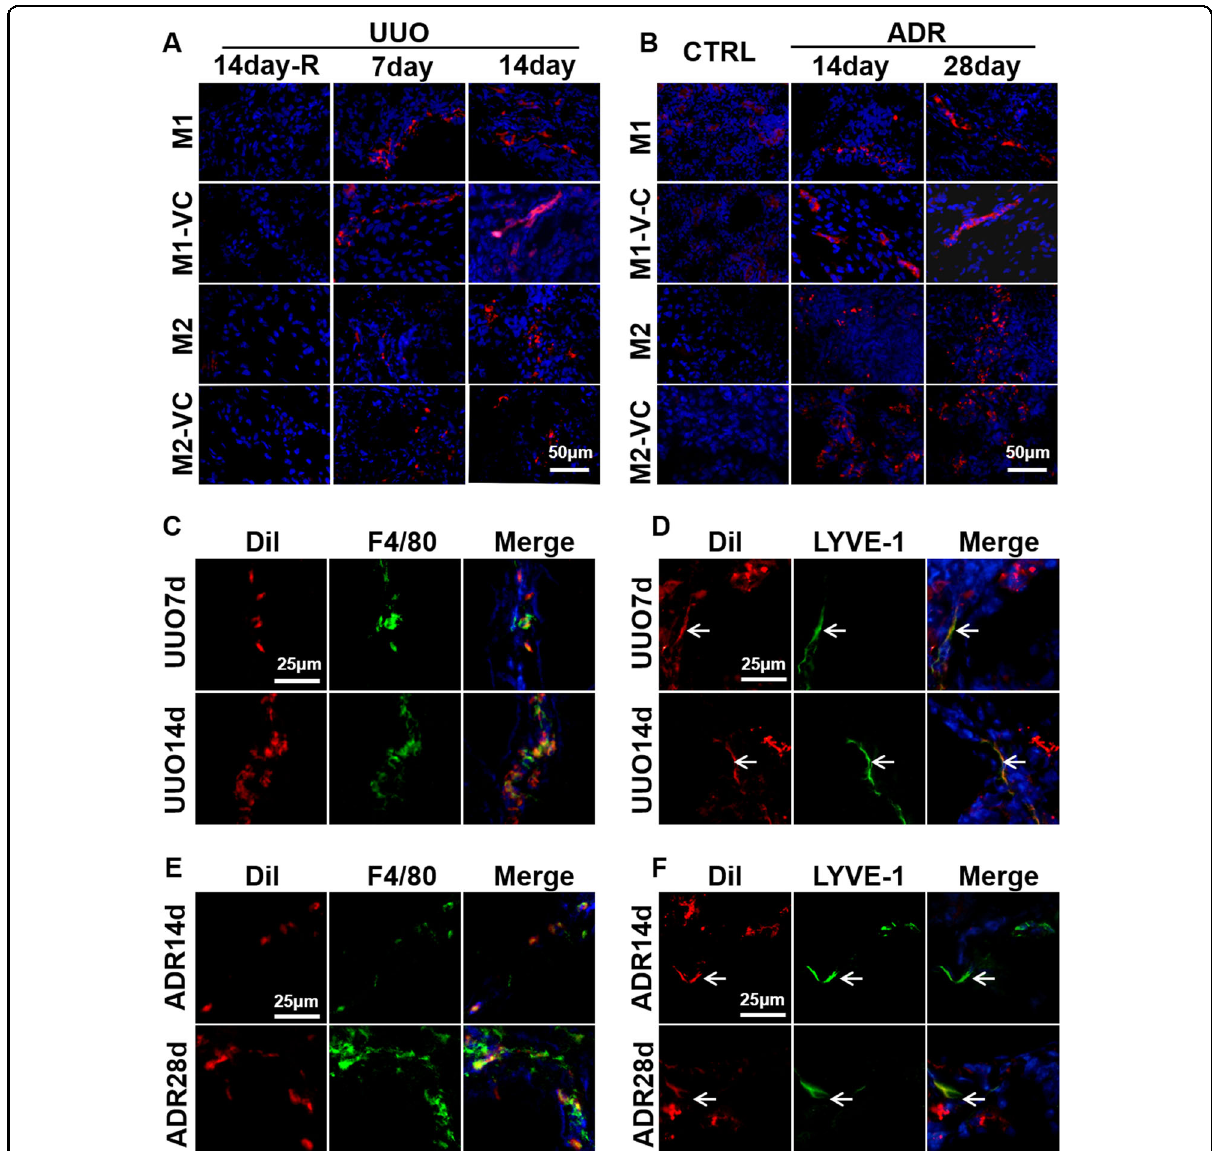
Fig. 6 Primary BMDMs formed tube-like structures in vivo. DiI (red)-labeled BMDMs (M1, M2) were injected into UUO mice ( A ) and ADR mice ( B ) through the tail vein. After sacri fi ce, the mouse kidney sections were directly analyzed by fl uorescence microscopy, and the operated kidney tissue was compared with the contralateral untreated kidney tissue. ADR mice were compared with saline-treated mice. Blue indicates DAPI-stained nuclei (400×). C – F Transferred DiI-M1 (red) cells were analyzed for coexpression of F4/80 ( C , E ) and LYVE-1 ( D , F ) in UUO ( C , D ) and ADR ( E , F ) mice by immuno fl uorescence (400×). N =